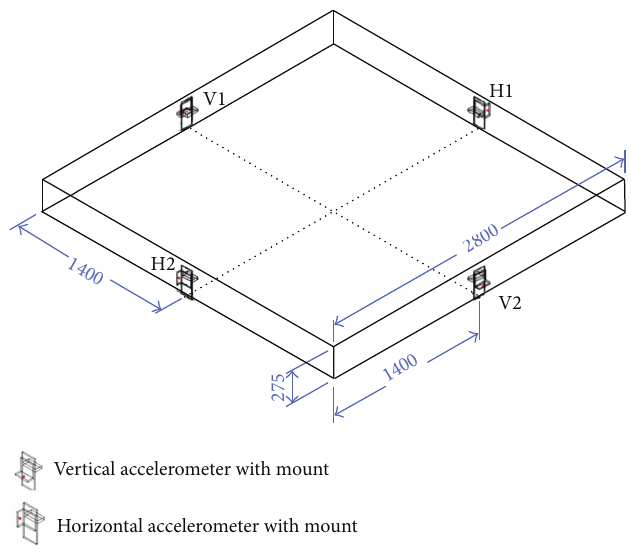
Figure 7: Layout of instrumentation for blast tests.